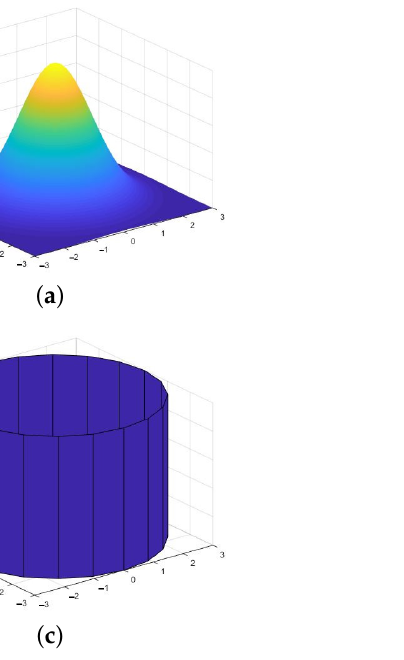
Figure 7. Depiction of the pdfs considered in simulating the spatial correlation mechanism: ( a ) bi- variate Gaussian pdf, ( b ) cuboid pdf and, ( c ) cylindrical pdf.